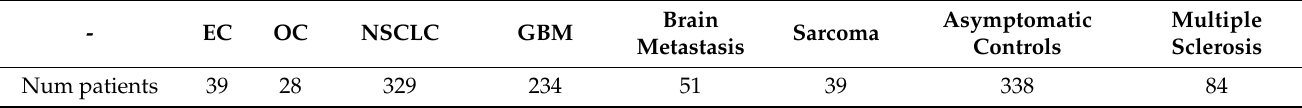
Table 1. Collected data